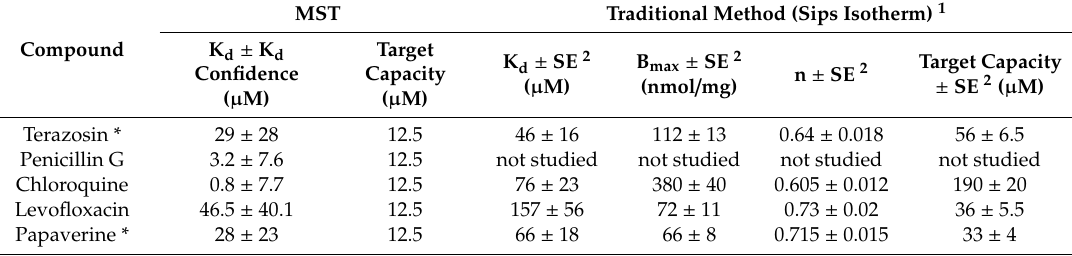
Table 2. Melanin binding parameters determined with microscale thermophoresis (MST) and traditional binding assay (Sips isotherm). Target capacity for Sips isotherm translated to MST assay using 0.5 mg / mL melanin